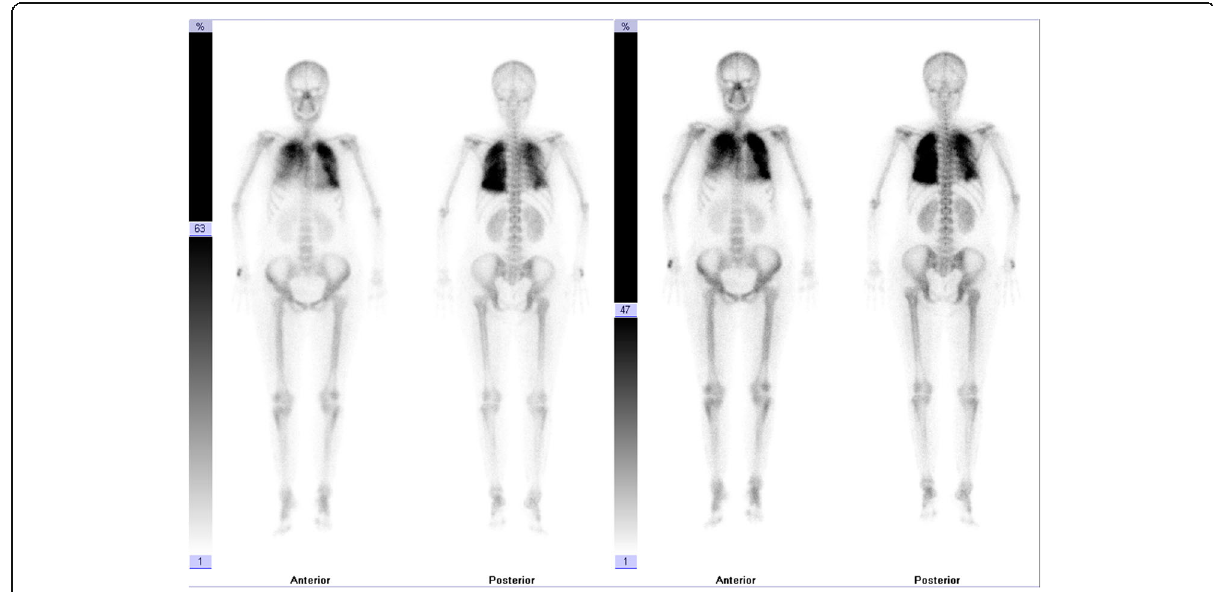
Fig. 4 Representative 99m Tc-MDP bone scintillation images showing pulmonary calcification. The patient was intravenously injected with 740 – 925 MBq 99m Tc MDP and emptied the bladder after 3 h. A SPECT instrument was used, which was equipped with a parallel low-energy high-resolution collimator. Anterior and posterior views were imaged at same time with scanning speeds of 15 – 20 cm/min and matrix 1024×256